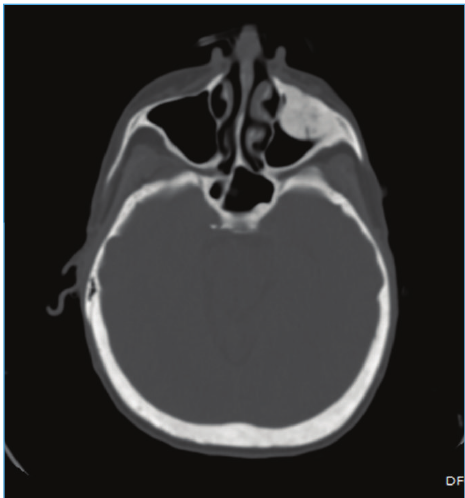
Figure 1: Axial noncontrast head scan at the level of maxillary sinus showing expansive sclerotic mass lesion within the left maxillary sinus without periosteal reaction.